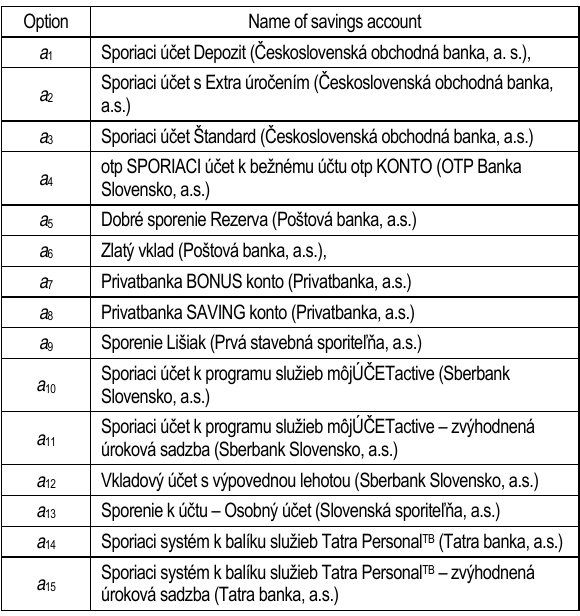
Table 2. Basic set of savings accounts